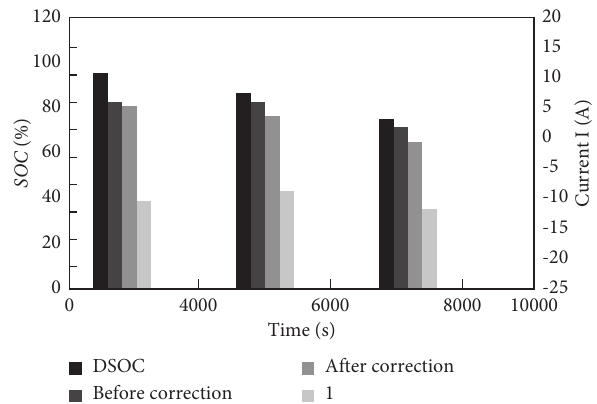
Figure 8: Comparison of SOC estimation before and after battery capacity modification.